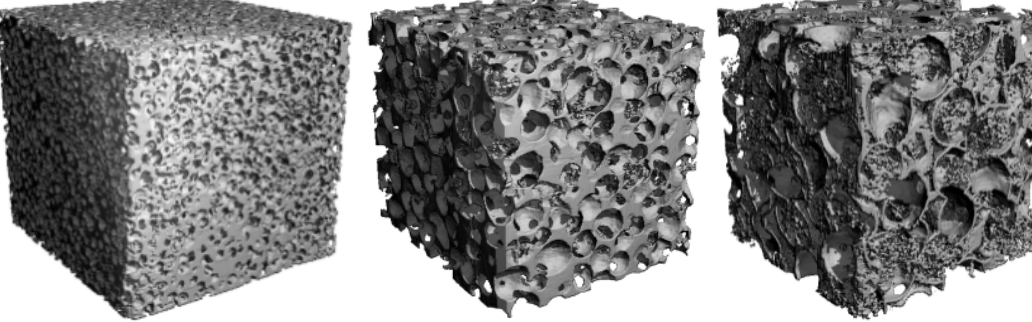
Figure 1. X-ray tomographic images of foams made from (left to right) 0.5–1.0, 1.4–2.0 and 2.5–3.1 mm beads compacted at 32